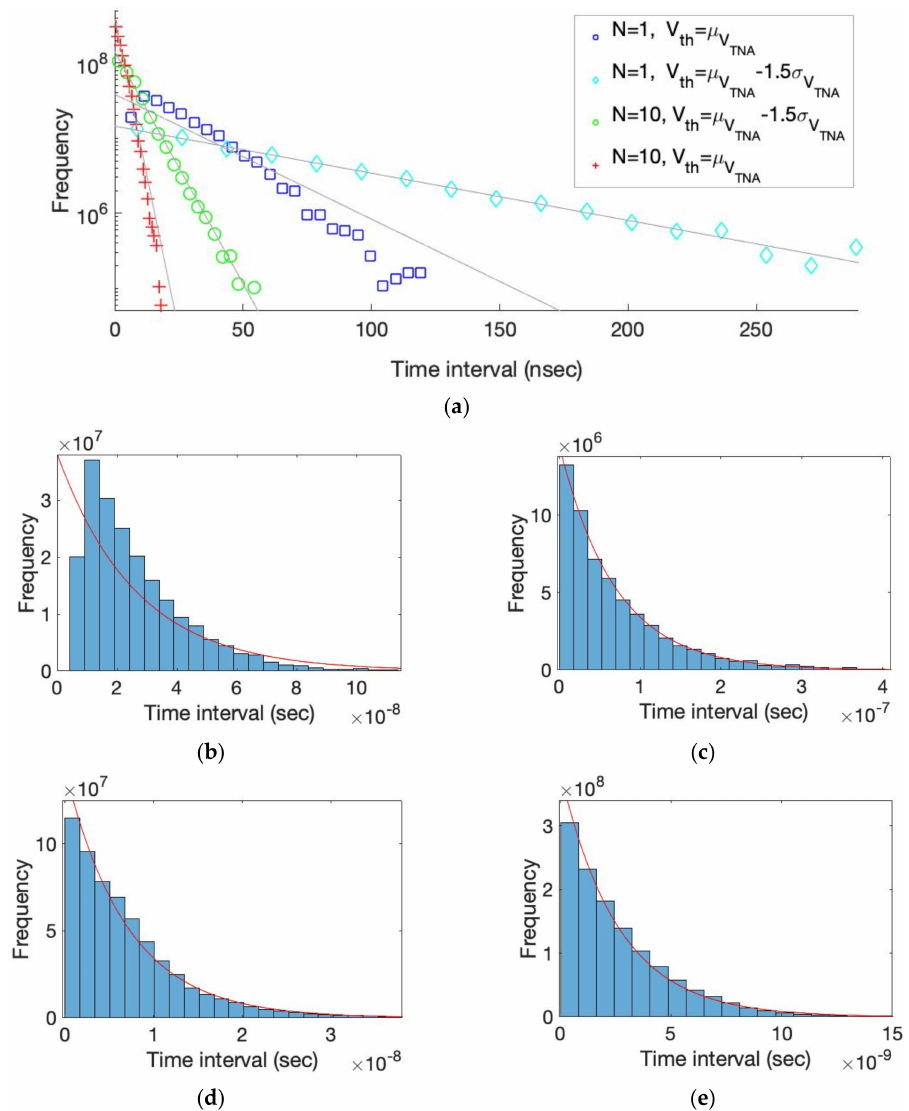
Figure 2. ( a ) Simulated time-interval histograms of the Poisson process generation in Figure 1a. ( b ) N = 1, V th (t) = µ VTNA , mean event rate = 38.02 MHz. ( c ) N = 1, V th (t) = µ VTNA − 1.5 σ VTNA , mean event rate = 14.4 MHz. ( d ) N = 10, V th (t) = µ VTNA − 1.5 σ VTNA , mean event rate = 142.4 MHz. ( e ) N = 10, V th (t) = µ VTNA , mean event rate = 382